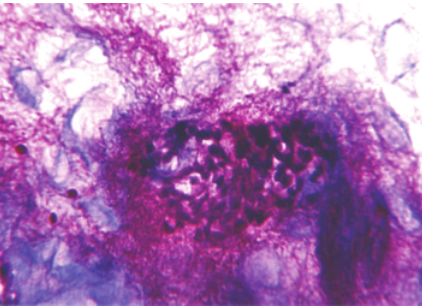
Figure 9: Islets of Langerhans resistant to necrotic changes (A). H&E ( × 400).